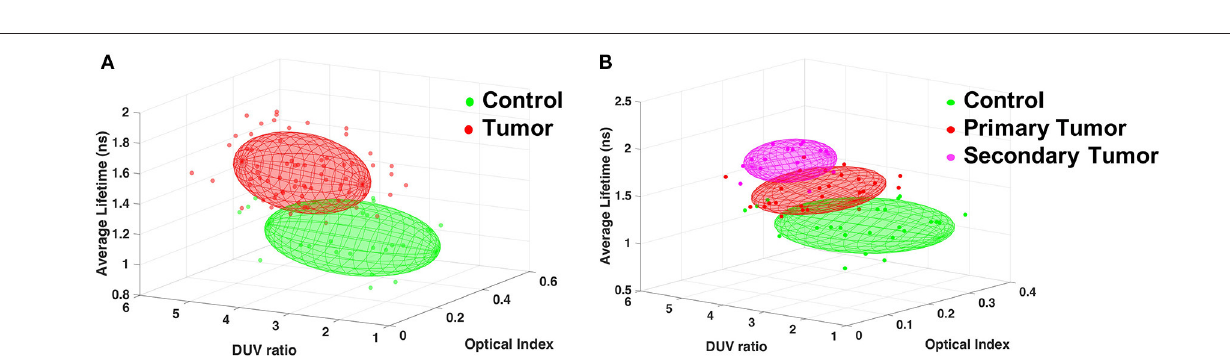
FIGURE 5 | Discrimination of tissue types combining three indicators: Porphyrin/NADH ratio using two-photon excitation (Optical Index), Tryptophan/collagen ratio at DUV excitation (DUV ratio) and the average lifetime using 890nm excitation. (A) Results comparing Control and any tumor types. (B) Results for Control, primary tumor (GBM) and secondary tumor